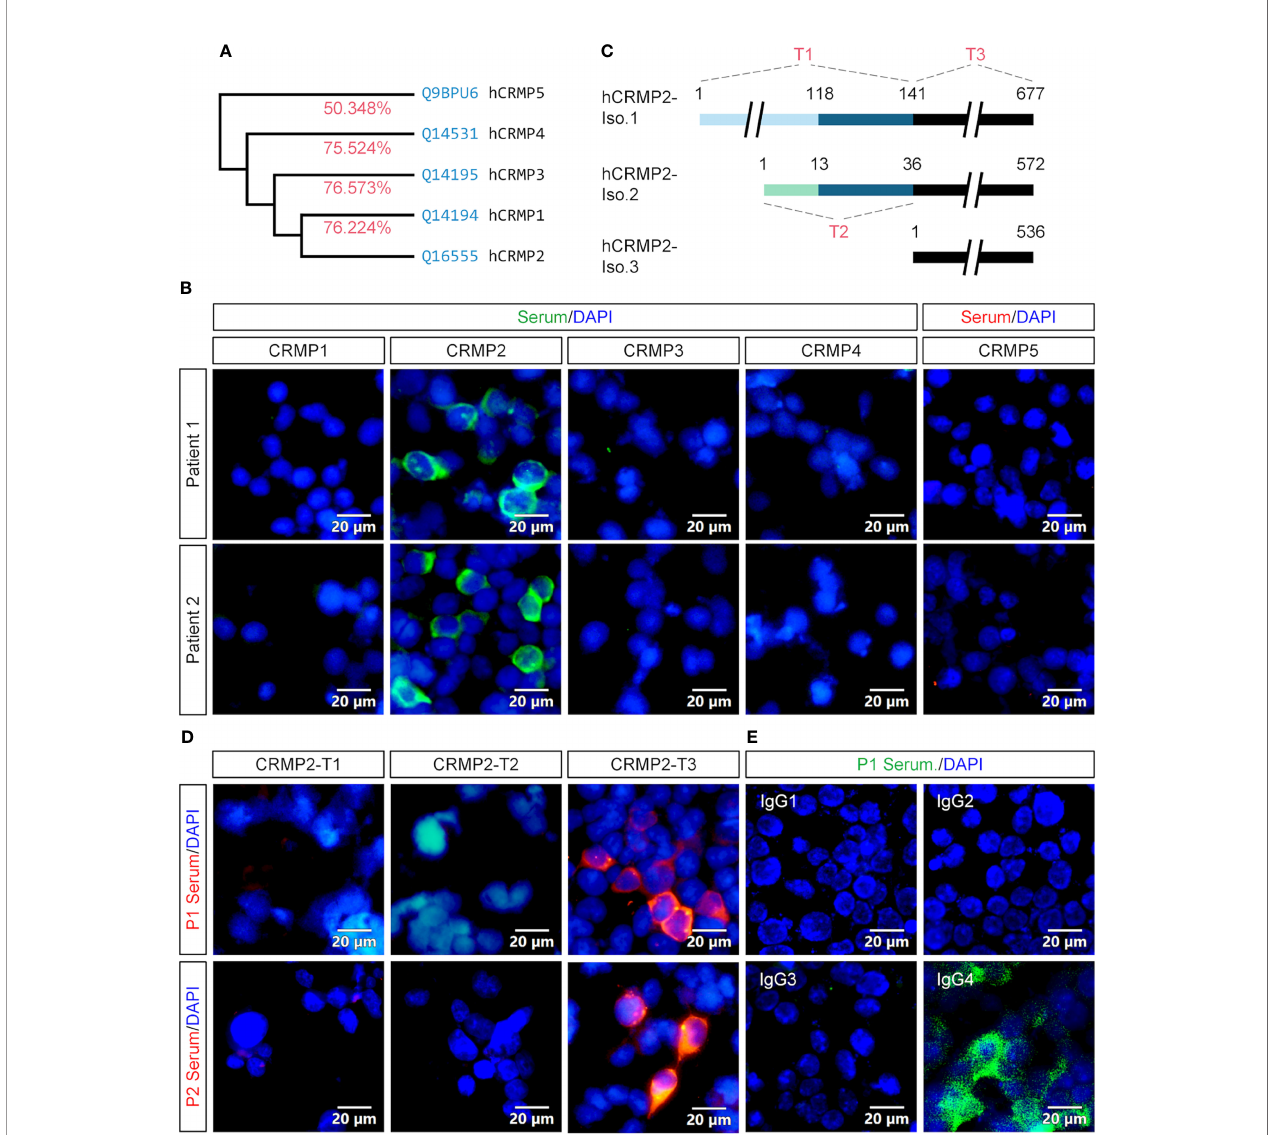
FIGURE 5 | Speci fi city, epitope, and IgG subtype determination of the antibody. (A) Homology analysis showed that CRMP2 had an identity (red) of 76.224, 76.573, 75.524, and 50.348% with CRMP1, CRMP3, CRMP4, and CRMP5, respectively. Blue, UniProtKB accession number. (B) CBA assay of the patients ’ sera for CRMPs. pcDNA3.1-based plasmids carrying CRMP1, CRMP2, CRMP3, CRMP4, and CRMP5-eGFP were transfected into HEK293T cells separately for protein overexpression. Secondary antibody anti-human IgG was labeled with green (CRMP1 – 4) or red (CRMP5) fl uorescence. Cell nuclei were stained blue with DAPI. P1 (upper panels) and P2 (lower panels) patients ’ sera were only immunoreactive with CRMP2 among CRMP family members. (C) Schematic drawings of the three CRMP2 isoforms and of the truncation strategy. The length or amino acid sites were indicated with numbers. Identical sequences between the isoforms were illustrated with the same line colors. (D) The pcDNA3.1-based plasmids carrying CRMP2 truncates T1, T2, or T3 illustrated in (C) were transfected into HEK293T cells separately for the CBA assay. P1 (upper panels) and P2 (lower panels) patient ’ s sera were reactive with T3 or 536 amino acid C-terminus of CRMP2 (red). (E) Immunostaining of CRMP2-expressing HEK293T cells with P1 patient serum and FITC conjugated anti-human IgG1-4 secondary antibodies. Positively stained in IgG4. CRMP, collapsin response mediator protein; DAPI, 6-diamidino-2-phenylindole; Iso., isoform. Scale bars represent 20 m m in (B) , (D) , and (E)